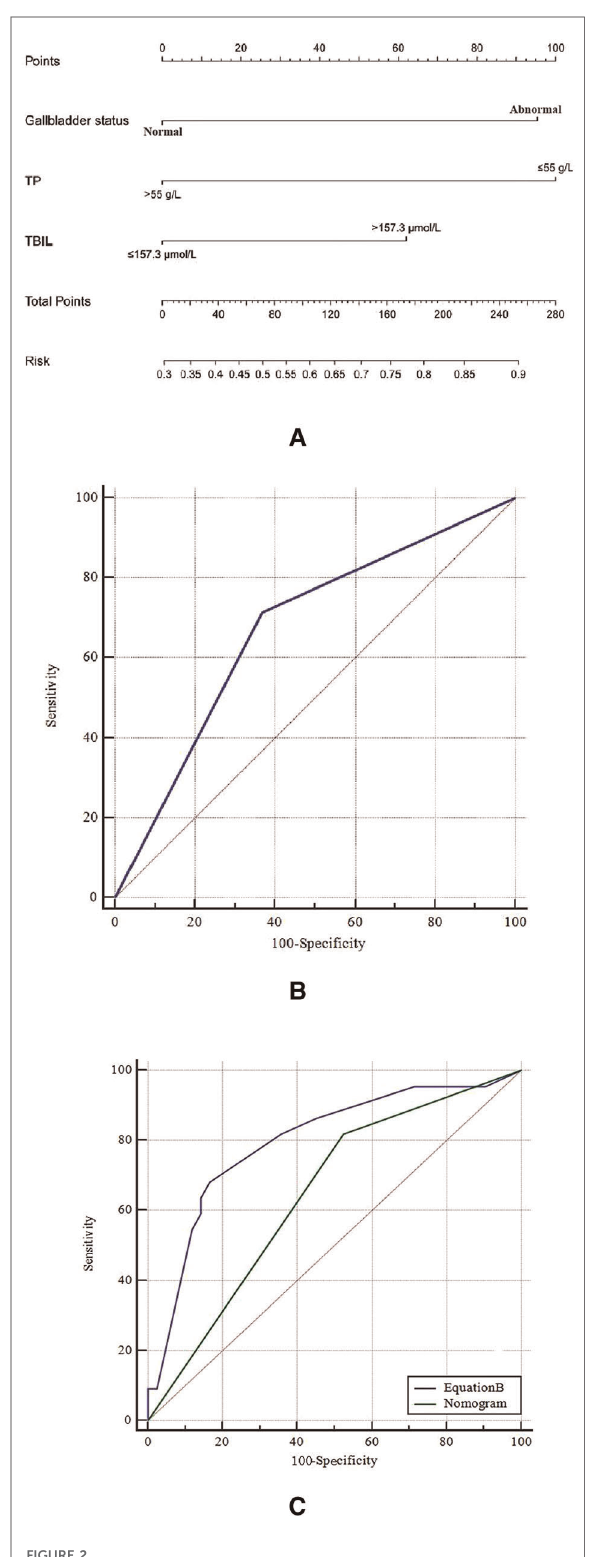
FIGURE 2 ( A ) the nomogram in the training cohort; ( B ) the receiver operating characteristic (ROC) curve of the nomogram in the training cohort; and ( C ) the comparison of ROC curve between the nomogram and equation B in the validation cohort. TP, total protein; TBIL, total bilirubin.